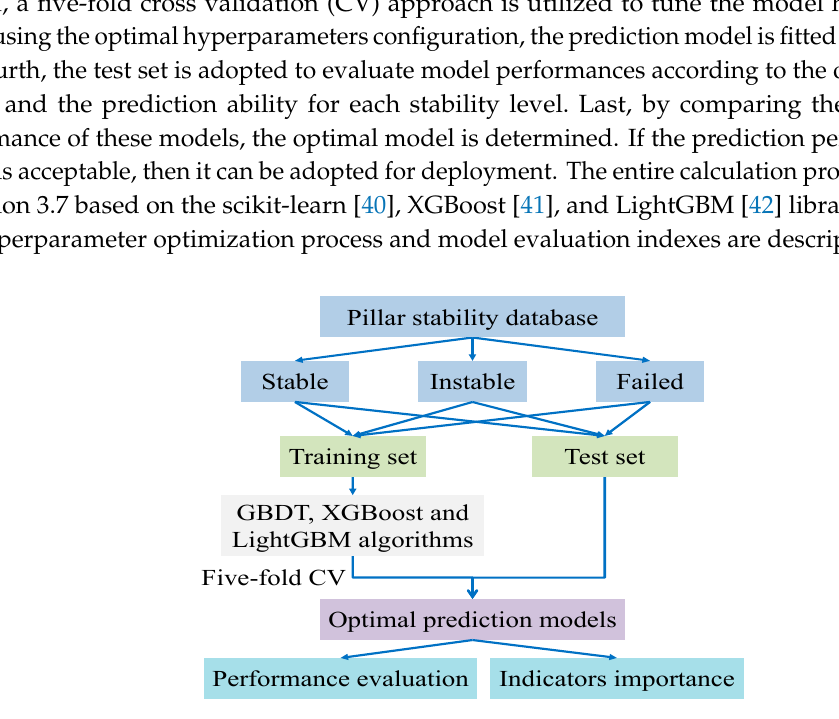
Figure 6. Construction process of prediction model.